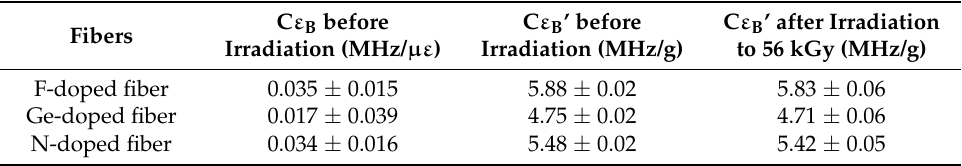
Table 4. Strain Brillouin coefficients in the unit of MHz/µ ε and MHz/g.